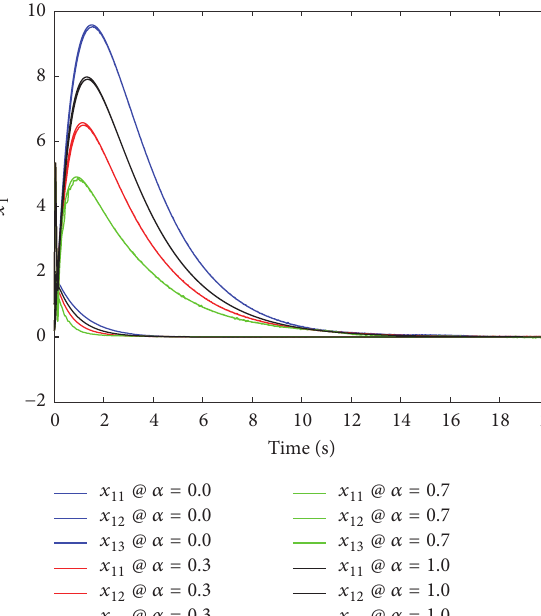
Figure 5: Gas generator state response 𝑥 2 .